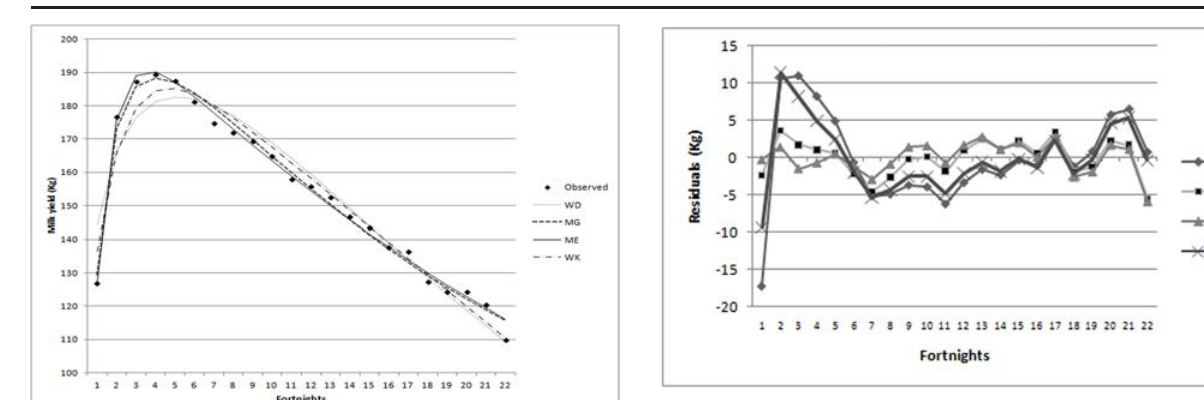
Figure-2: Residuals of the fortnightly milk yield for different lactation curve